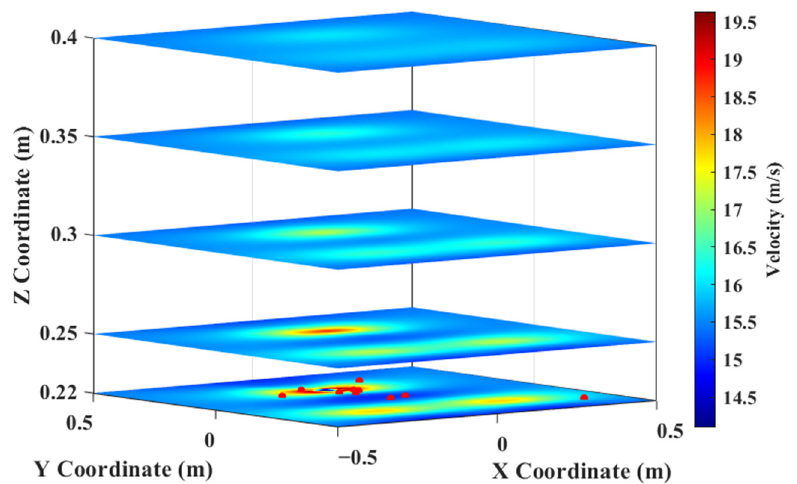
Figure 19. Reconstructed velocity nephograms with optimal sensor locations (Boundary Condition 1).